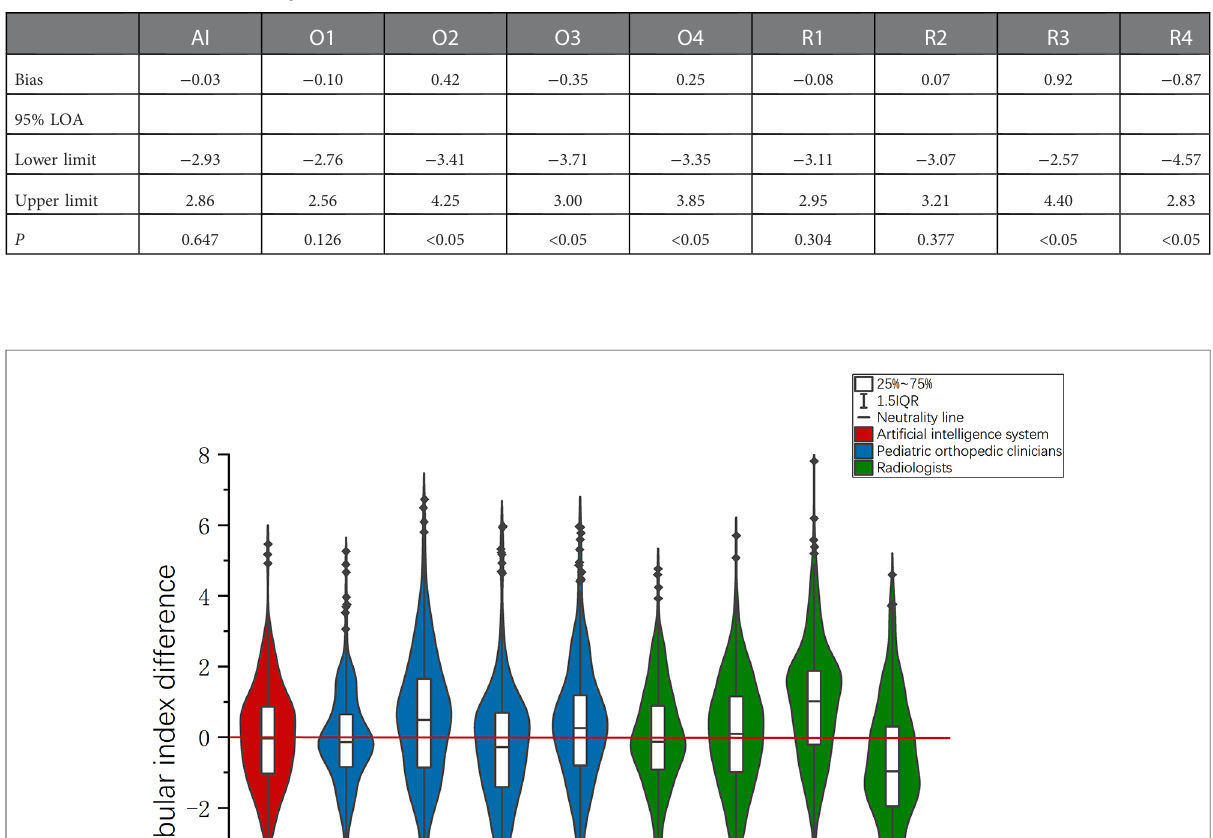
TABLE 2 Bland – Altman consistency test results.